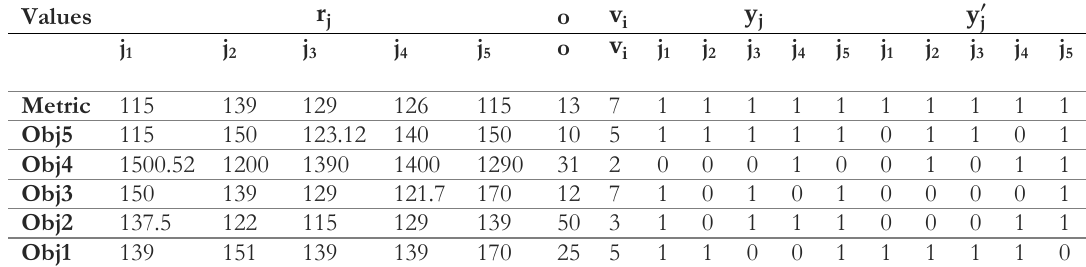
Table 4. The values of objective functions for different rj, O, vi, yj, and y'j.